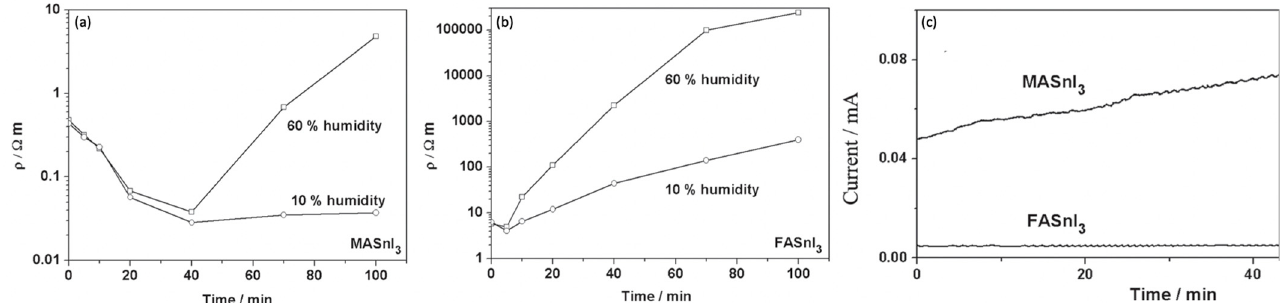
Figure 3. As a function of time and humidity, the resistivity of ( a ) MASnI 3 and ( b ) FASnI 3 . ( c ) In a glovebox in the dark, the MASnI 3 and FASnI 3 conductor structures were characterized by the current they carry when biased by 1 V. Reproduced with permission [63]. Copyright 2016, WILEY-VCH.